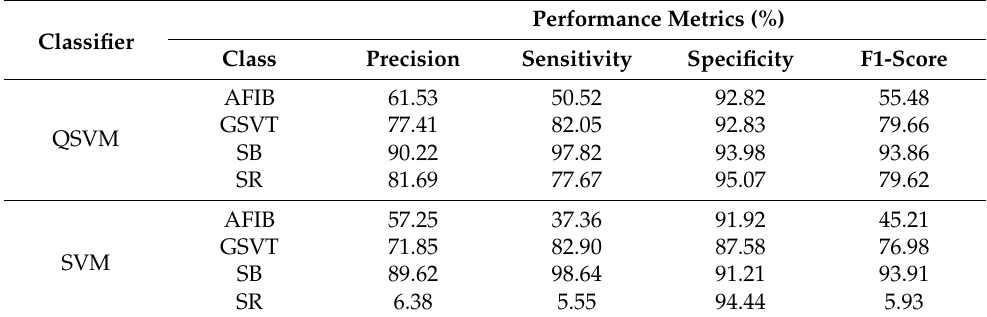
Table 3. Comparisons of quantum support vector machine (QSVM) and support vector machine (SVM) classi fi er performance metrics, detailed.